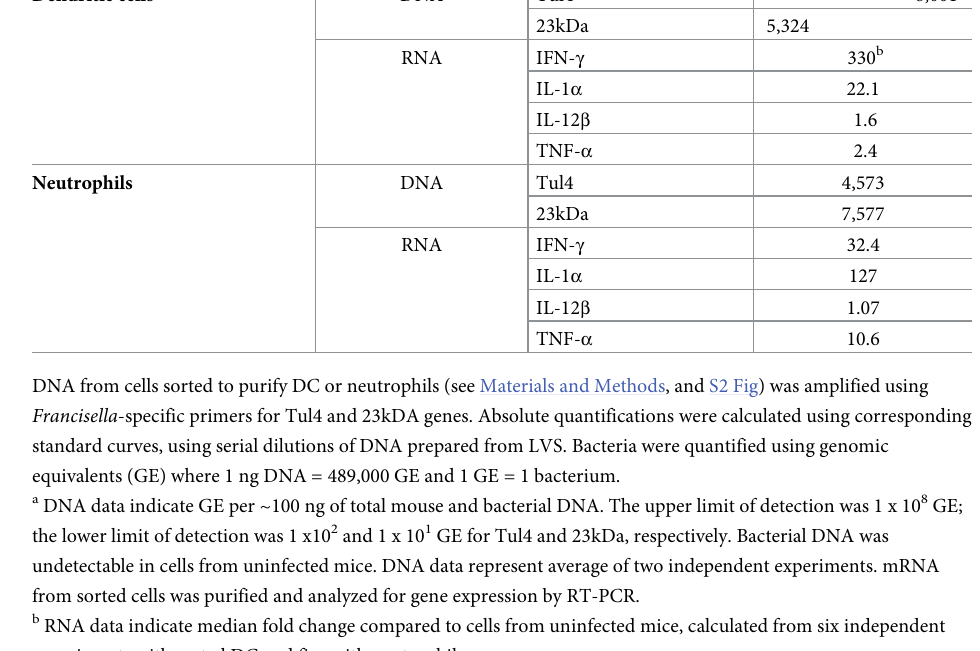
Table 1. LVS infects both DC and neutrophils in vivo , but cytokine gene expression varies between cell types.